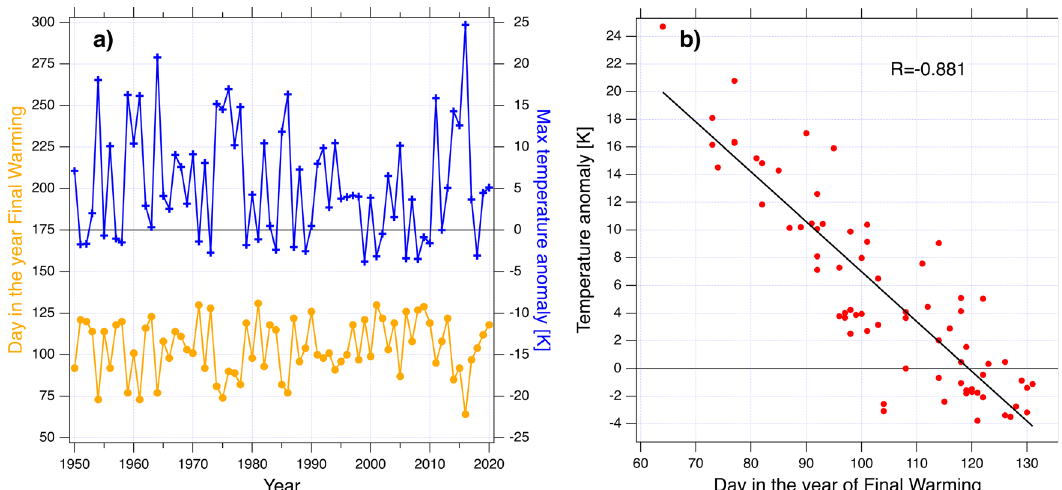
Fig. 1 FSW date and temperature anomaly. a Final warming day (in light orange, left scale) and fi nal warming temperature anomaly (in dark blue, right scale). b Correlation between the fi nal warming day in the year and the polar temperature anomaly. The black line represents the linear regression (correlation coef fi cient R = −